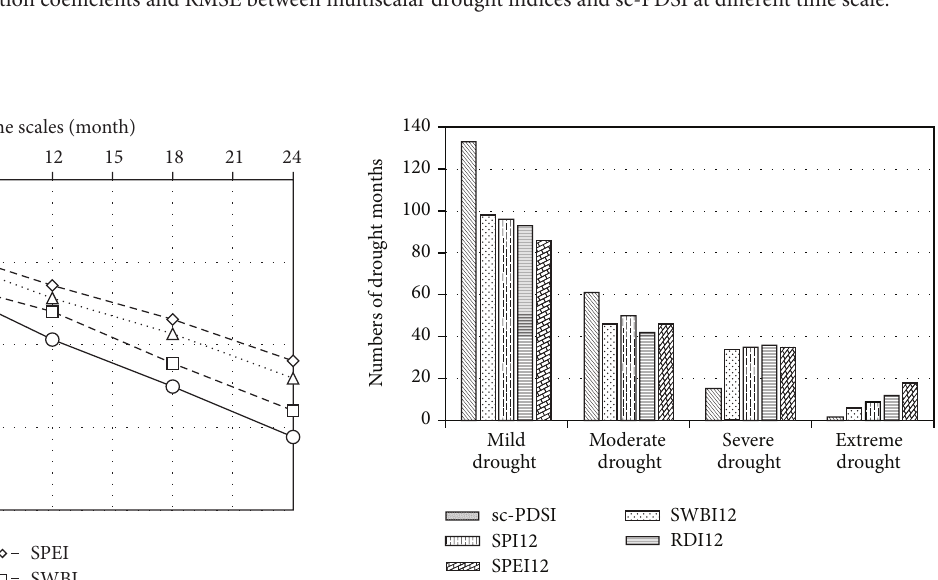
Figure 7: Pearson correlation coefficients and RMSE between multiscalar drought indices and sc-PDSI at different time scale.